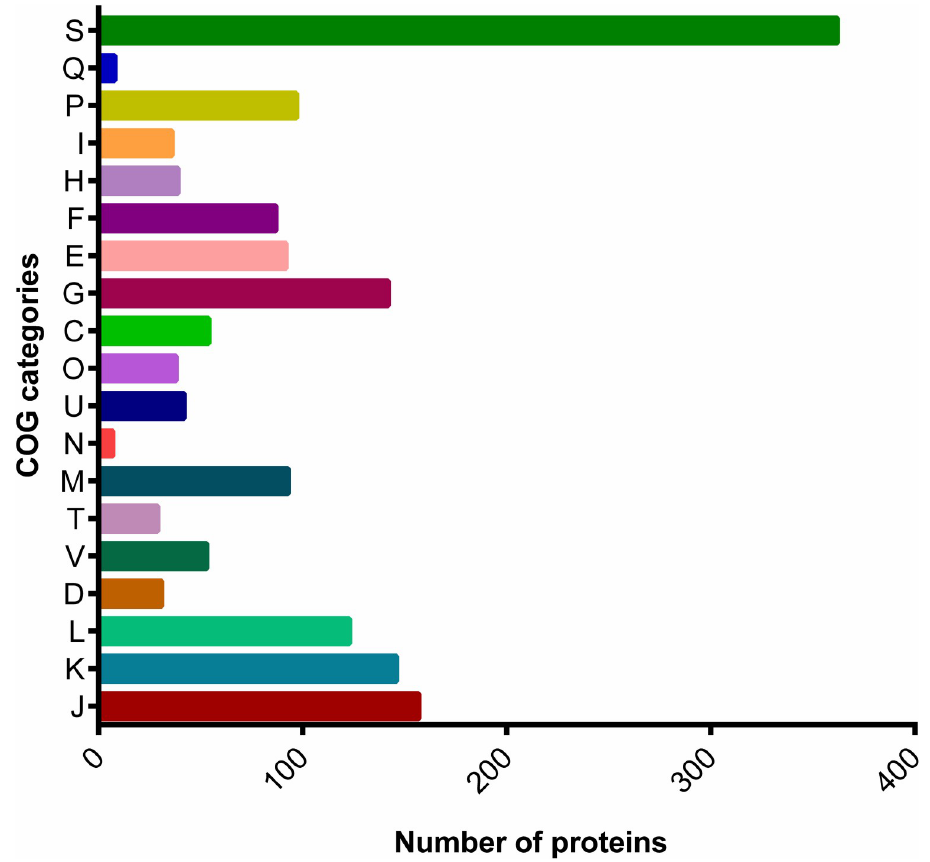
Fig 2. COG functional categories assigned to the proteins of Lactobacillus paragasseri UBLG-36.